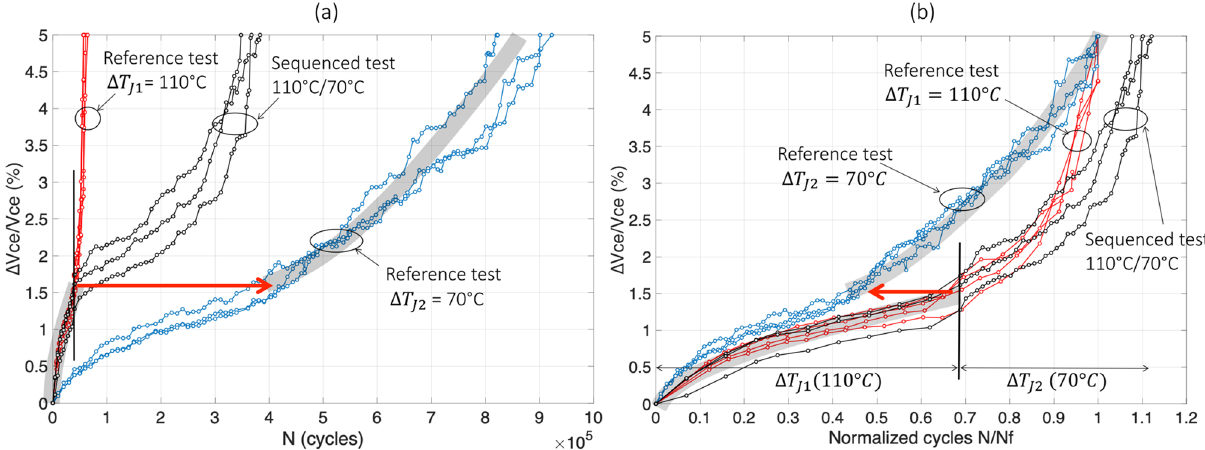
Figure 5. The sequenced test 110 °C/70 °C (test#7), normal scale in cycles ( a ) and normalized in N f ( b ).